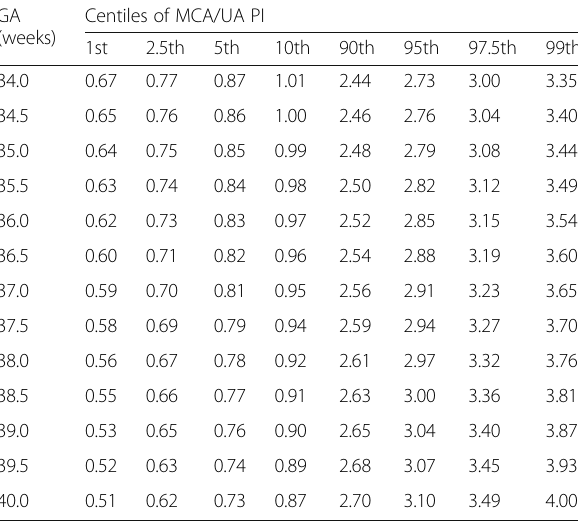
Table 5 Gestational age-defined reference ranges for MCA PI/ UA PI ratio